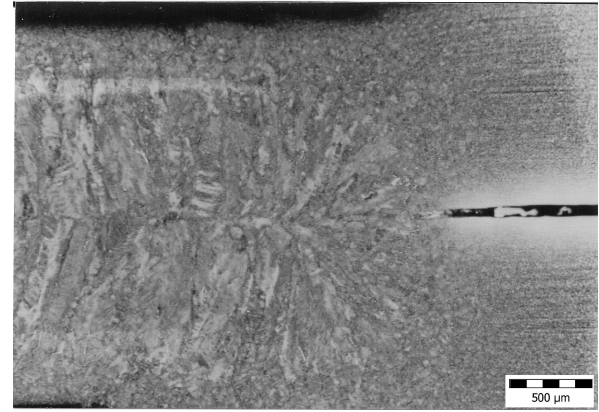
Figure 10: Microstructure of the weld with a cavity in the middle of nugget of sample D.